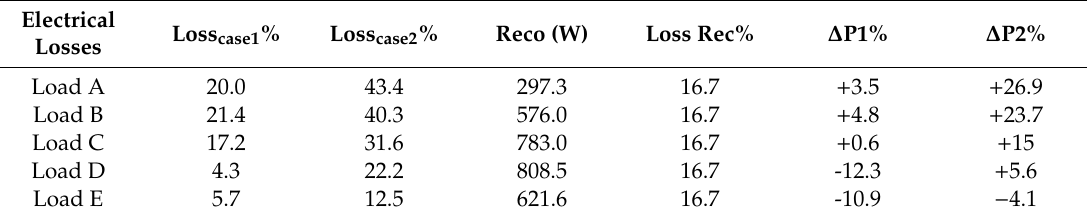
Table 11. Electrical Characteristics in di ff erent loading conditions evaluated by reconfigurator for each